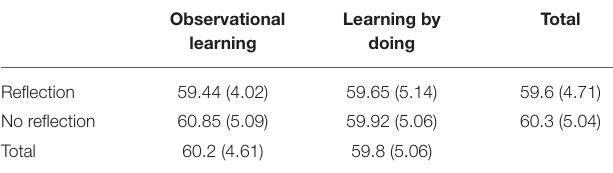
TABLE 7 | Self-efficacy Scores (SD) in relation to Instructional Method and Reflection (min. score 0, max. score 100). Observational